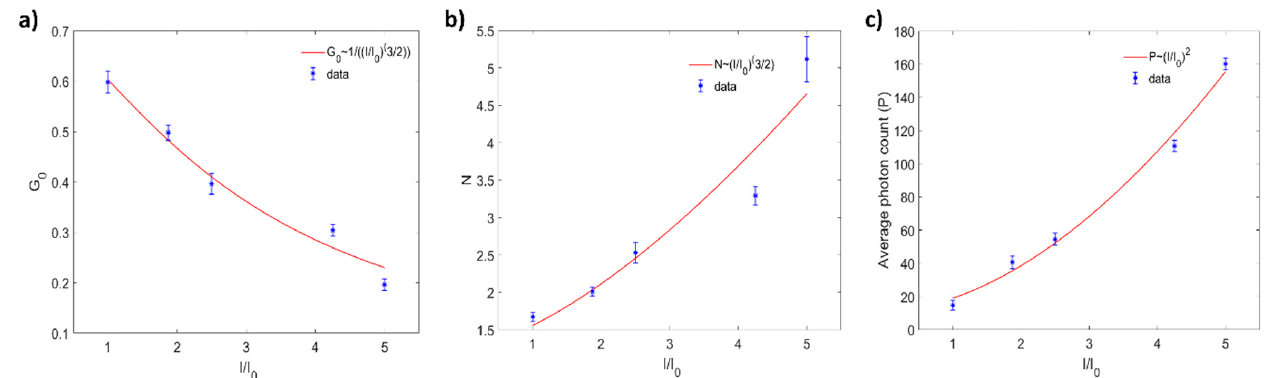
Figure 8. Plot of the ( a ) autocorrelation amplitude function G(0) acquired using simple data fit (G(0) ~(I/I 0 ) 3/2 ) and ( b ) number of particles N using data fit (N~(I/I 0 ) 3/2 ) on autocorrelated data (time binning 10,000 ns) from experimental measurements of a Rhodamine B solution (10 nM), the 63 × (NA 1.2) objective lens as a function of different laser powers. ( c ) the effect of excitation intensity on an average photon count. Data points in blue and red line is fitting.